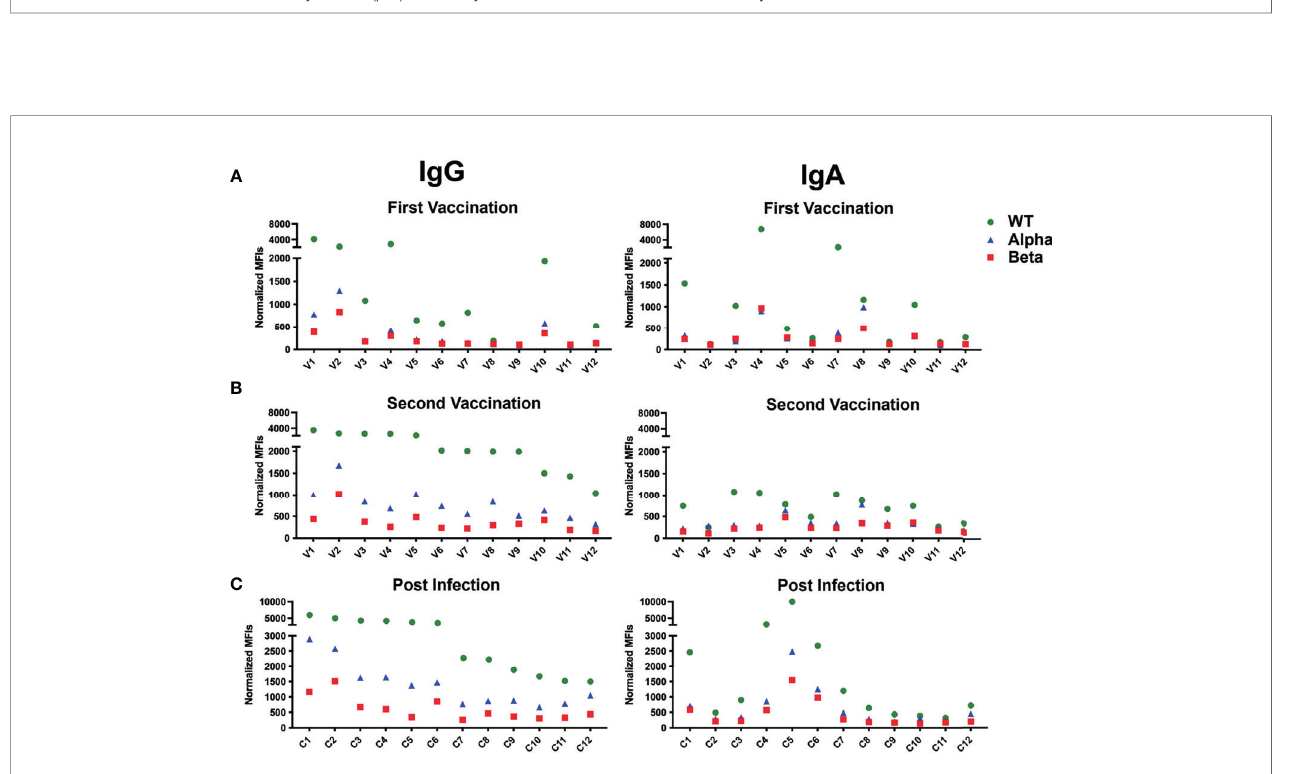
FIGURE 5 | BSFA study of the sera of 12 persons vaccinated with the BioNTech/P fi zer mRNA vaccine after the primary (A) and secondary (B) vaccine doses and of 12 patients with severe COVID-19 disease (C) . Summary of the production of S protein-speci fi c IgG (left panel) or IgA (right panel) antibodies. The sera were diluted 1:100 and analyzed by fl ow cytometry for antibodies binding to Ramos cells expressing either the WT (green), the alpha variant (blue) or the beta variant (red) S protein. Shown are normalized mean fl uorescence intensity